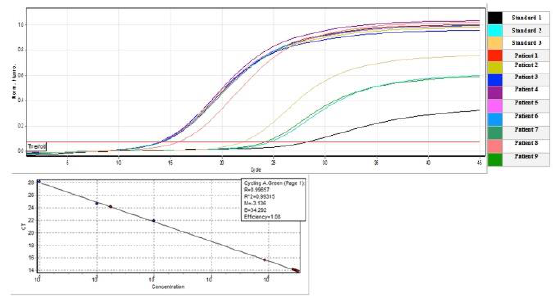
Figure 1. Viral Load Results of Nine Patient Samples and Three Standards